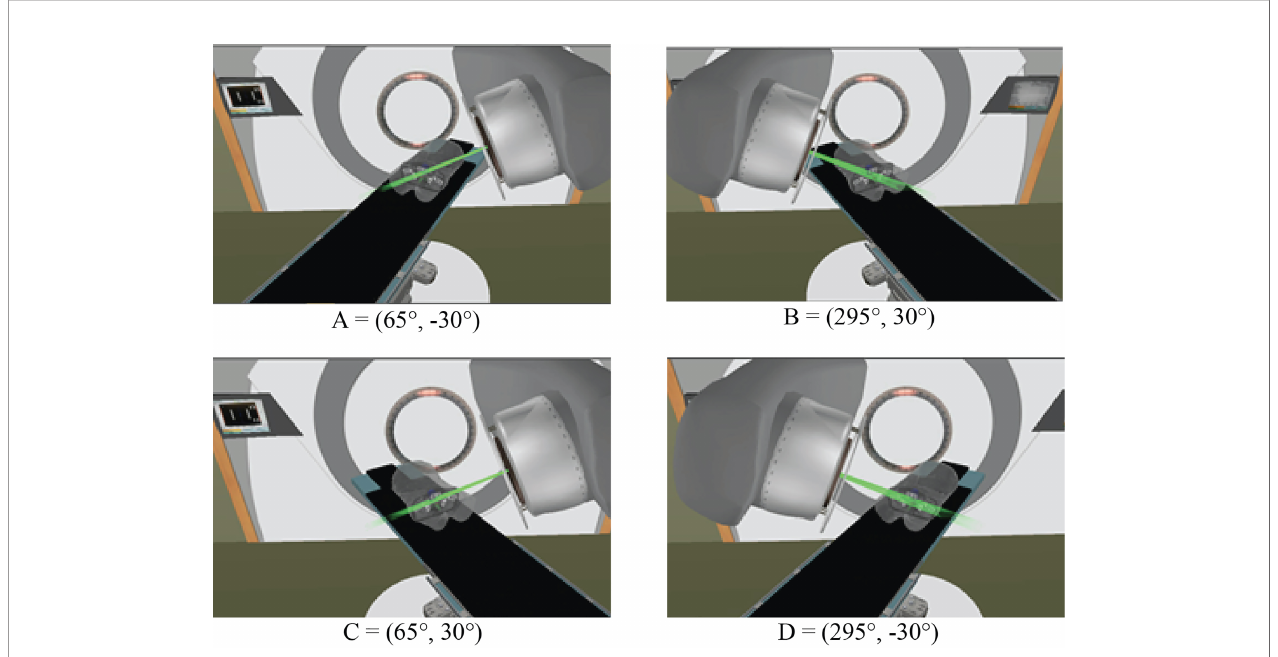
FIGURE 3 | Four principle beam directions, characterized by (gantry angle, couch angle), from Figure 2 , used to develop the fi nal class solution for VMAT+CS. This fi nal CS consisted of directions C and